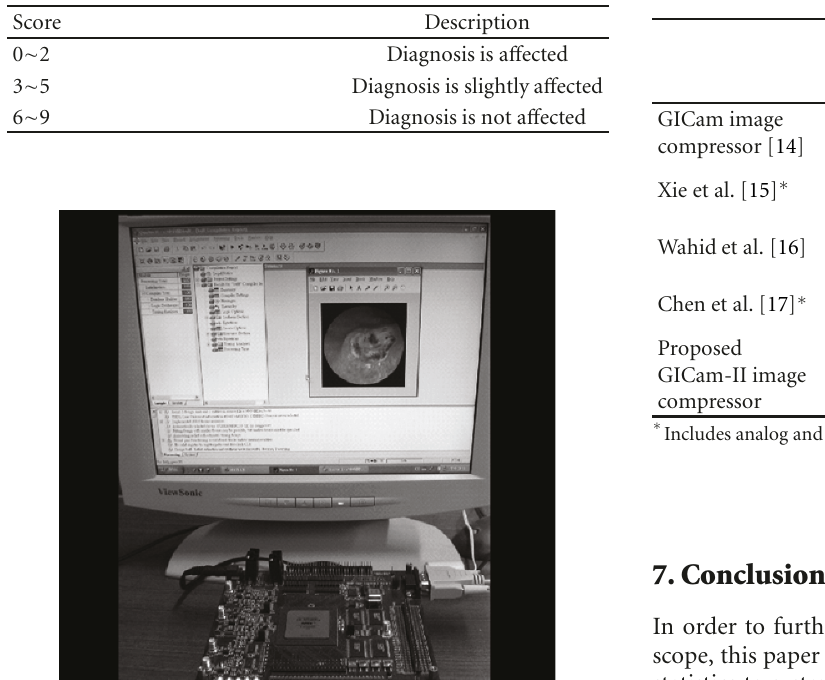
Table 5: The criterion of evaluation.